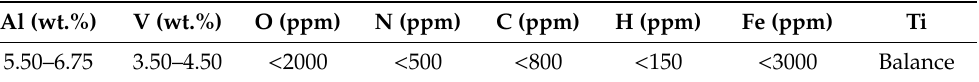
Table 1. Nominal composition of EOS Ti64 powder from the material